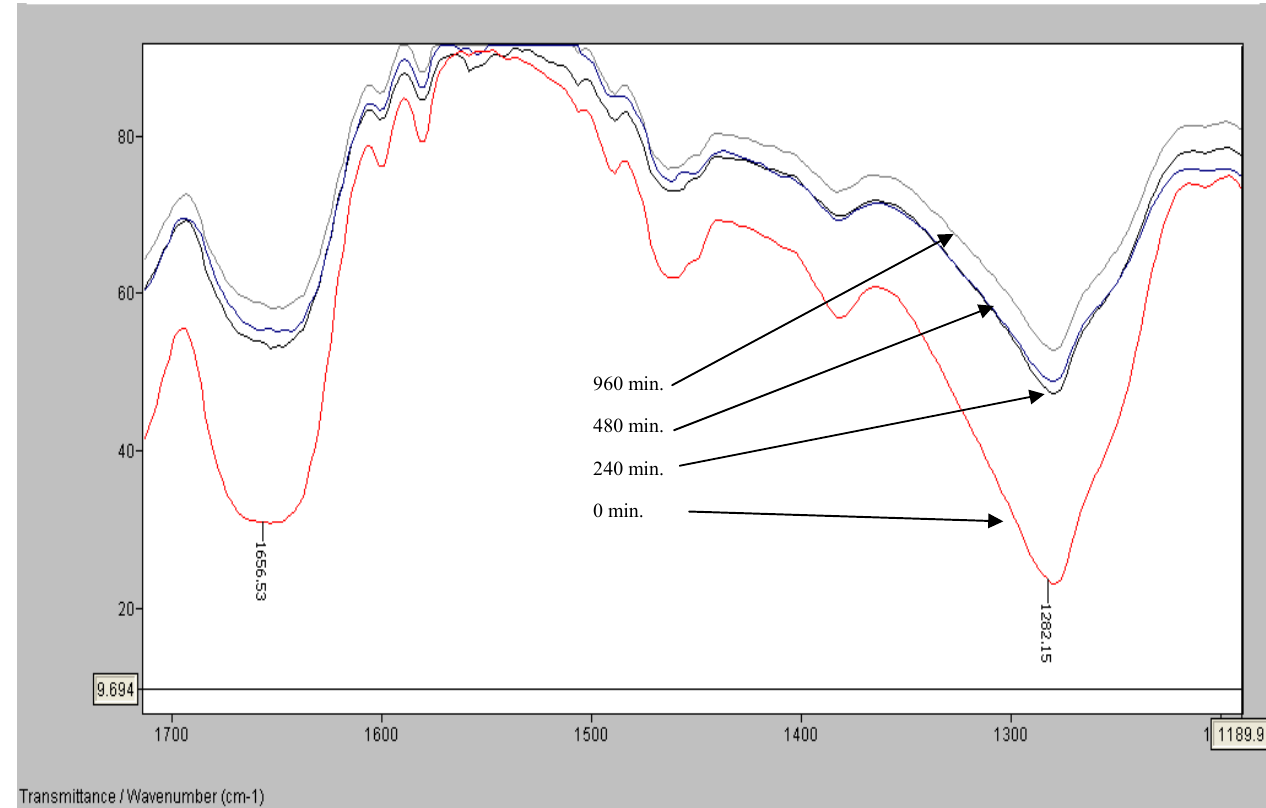
Figure 4. Comparative FTIR spectrum of the nitric group for: a) sample I, b) sample II, c) sample III, d) sample IV.